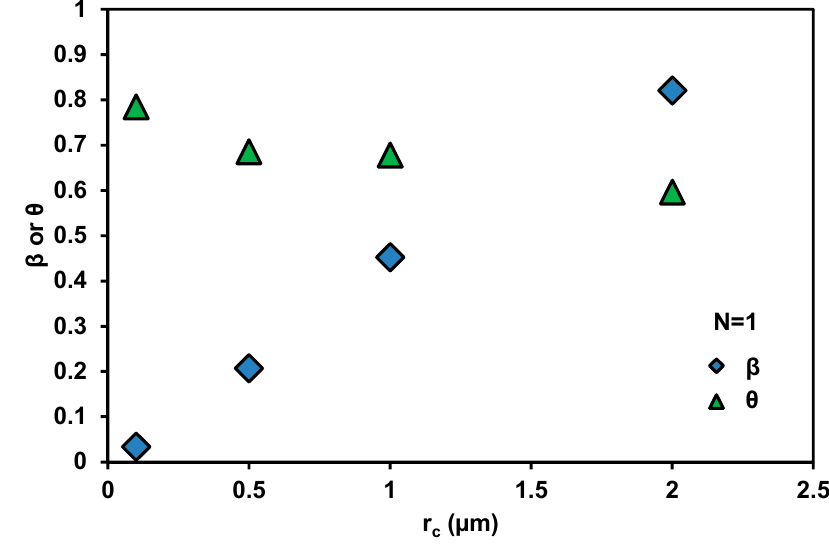
Figure 8. Calculated β and θ for Figure 2.